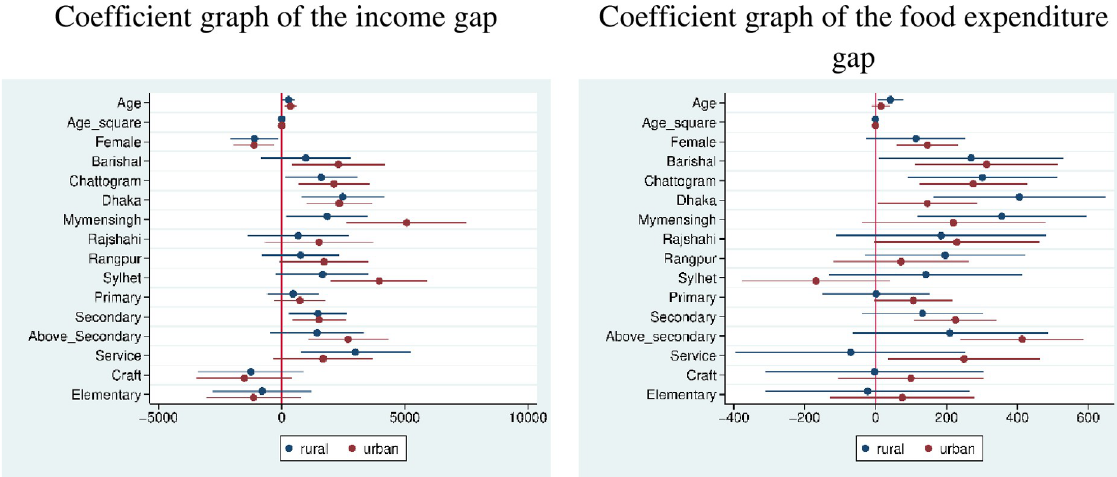
Fig 5. Coefficient graphs of the income and food expenditure